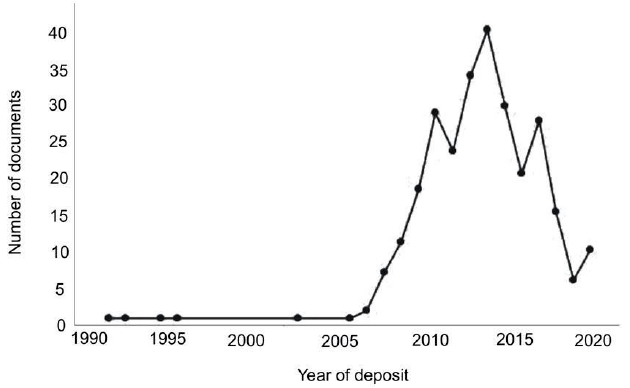
Figure 5. Number of documents by years.